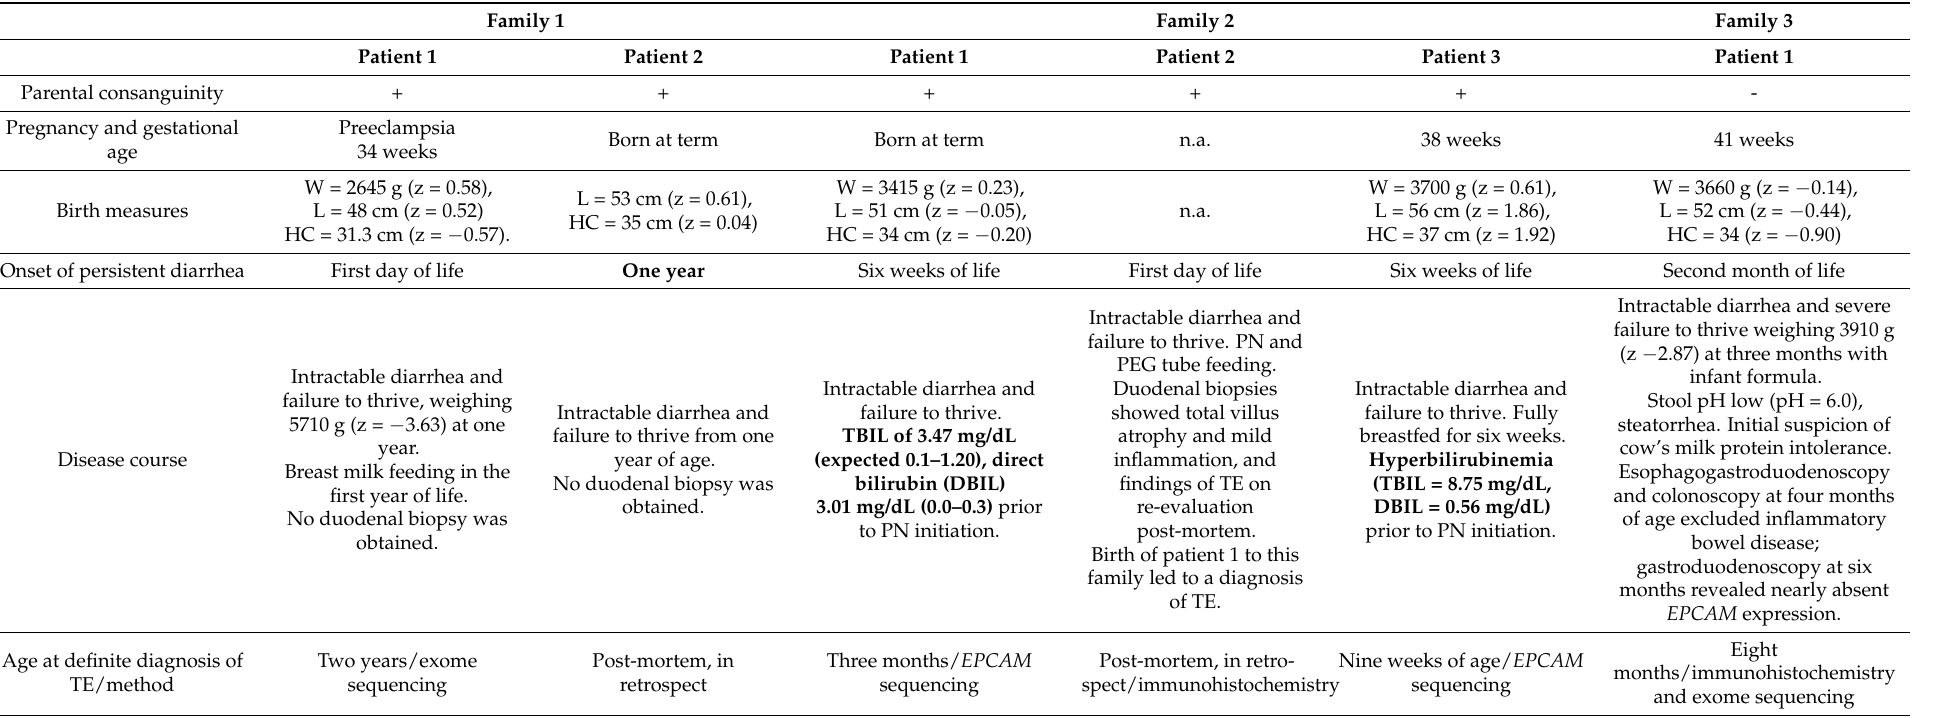
Table 1. Clinical findings in this